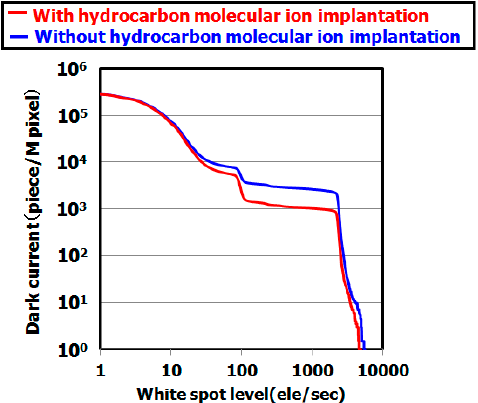
Figure 7. Dark current level after CMOS image sensor fabrication process on epitaxial silicon wafers with and without hydrocarbon–molecular–ion implantation. The epitaxial thickness is 7 µ m and hydrocarbon dose amount is 1 × 10 15 cm − 2 . The dark current levels were measured by dark current spectroscopy under 60 °C.